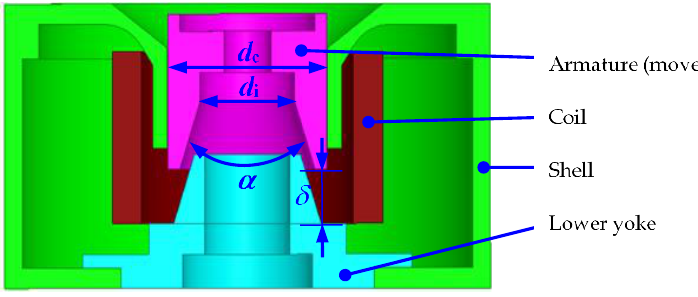
Figure 7. Parameters for solenoid actuator with conical air gap